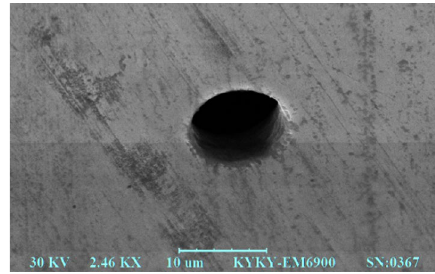
Figure 5. EM photo of micro hole at k 2 = 0.7 and k 1 = 0.2.